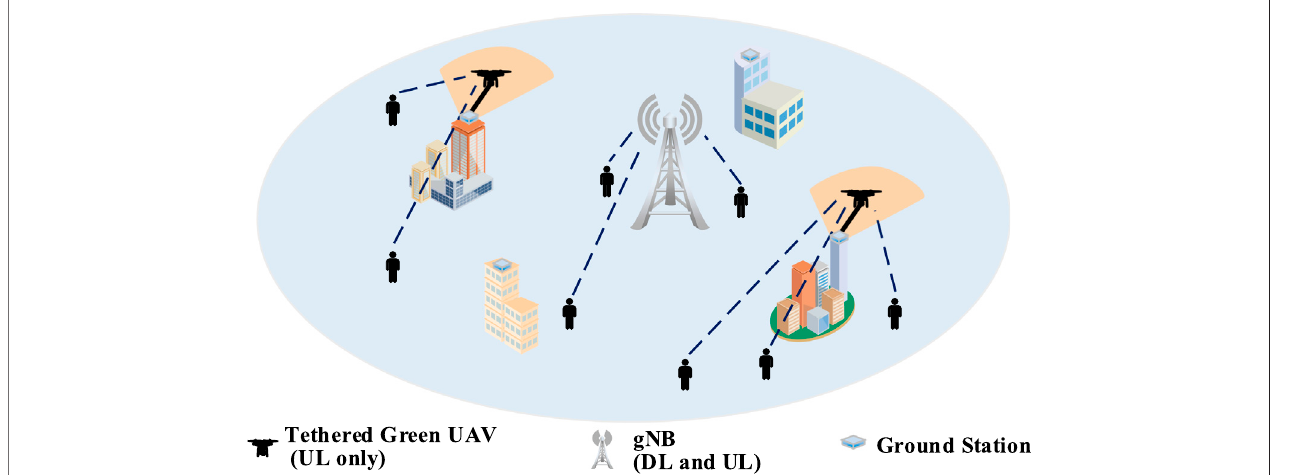
FIGURE 1 | The proposed EMF-aware cellular system design using tethered green UAVs for beyond 5G networks.